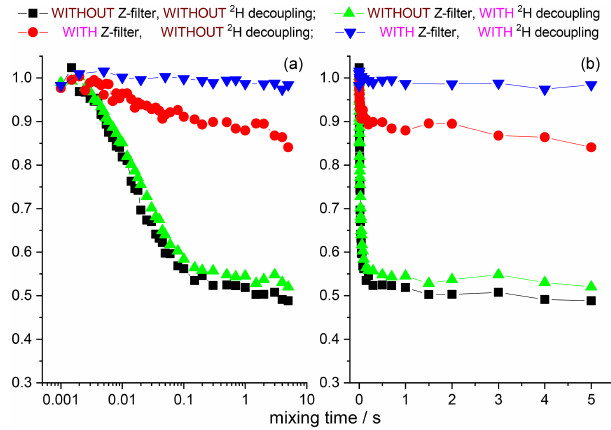
Figure 13. The same data at the same conditions as shown in Fig. 12 for SH3.